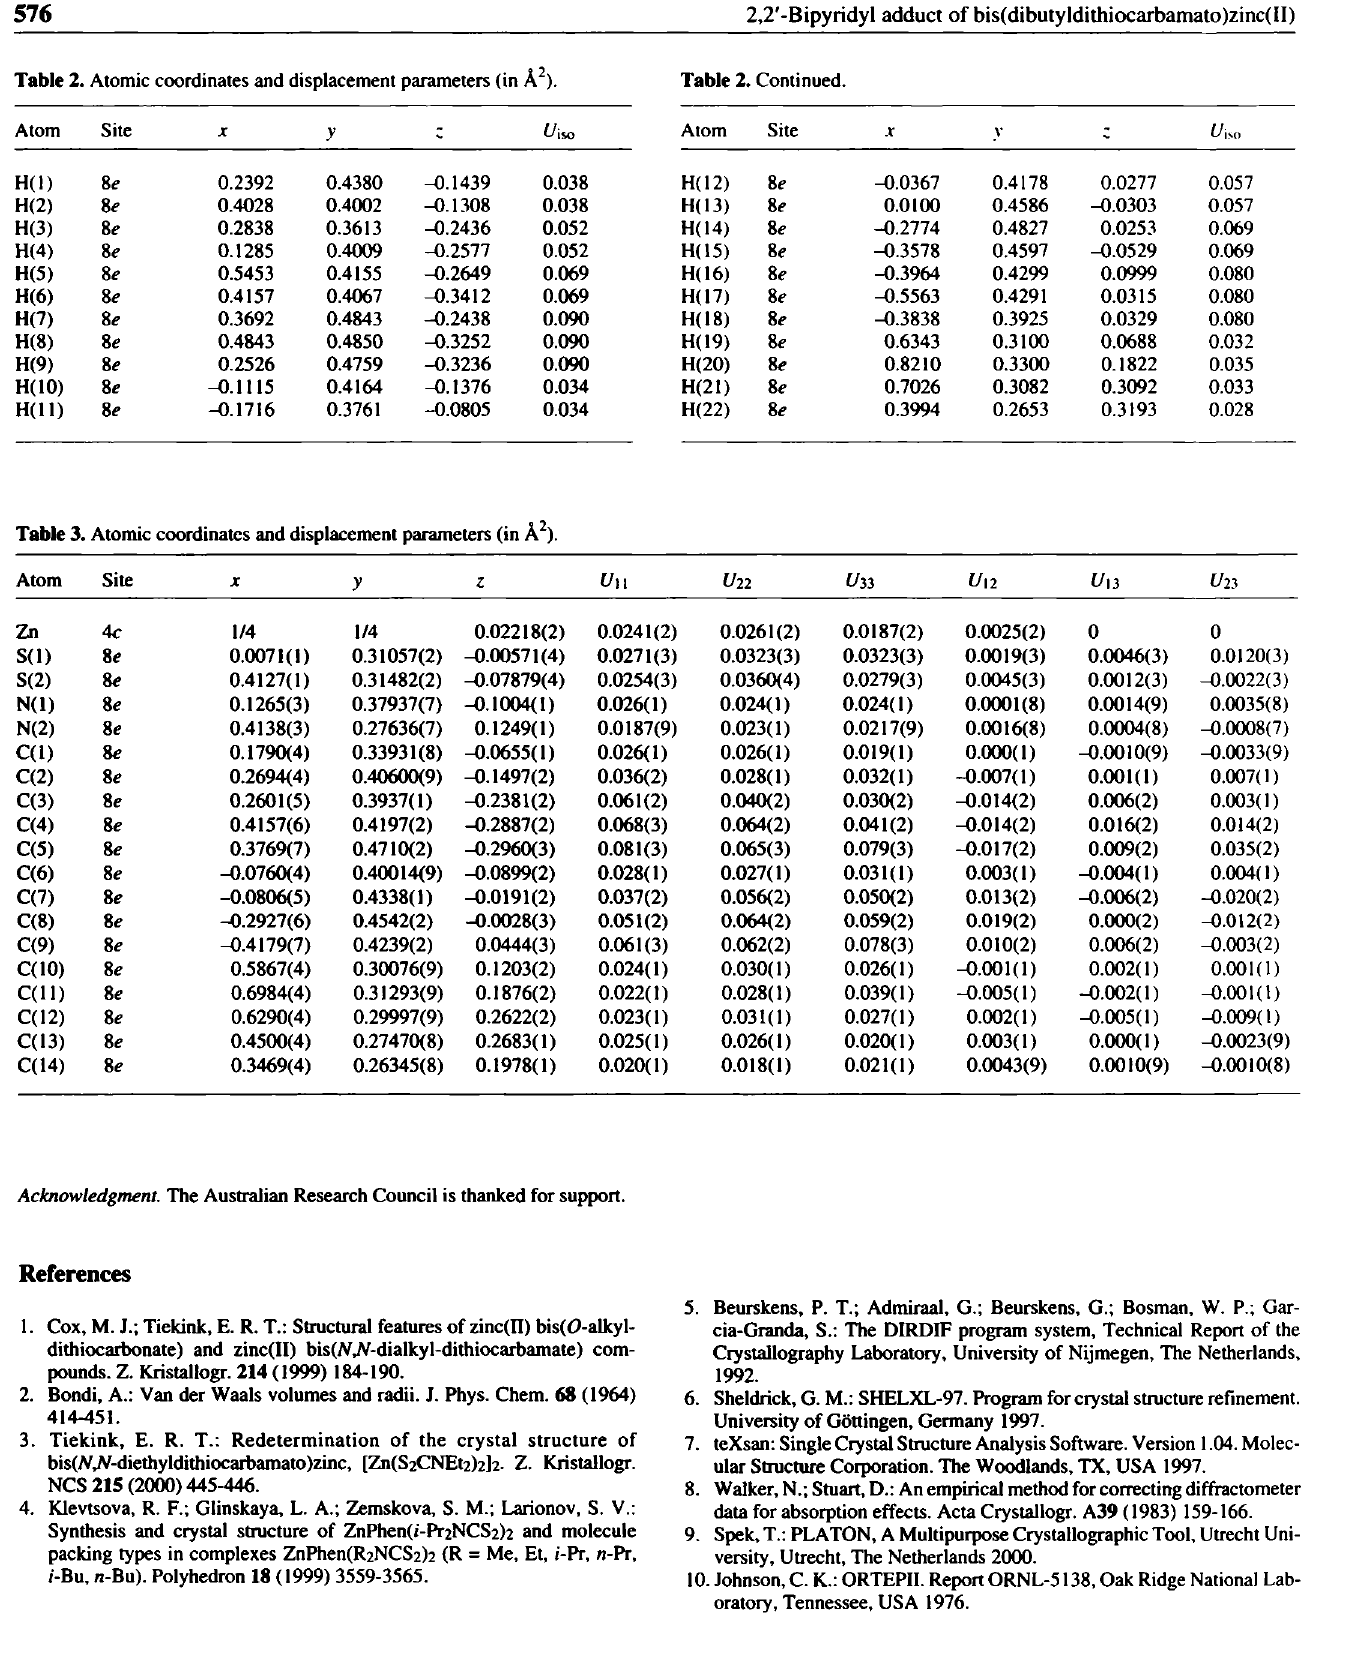
Table 3. Atomic coordinates and displacement parameters (in A 2